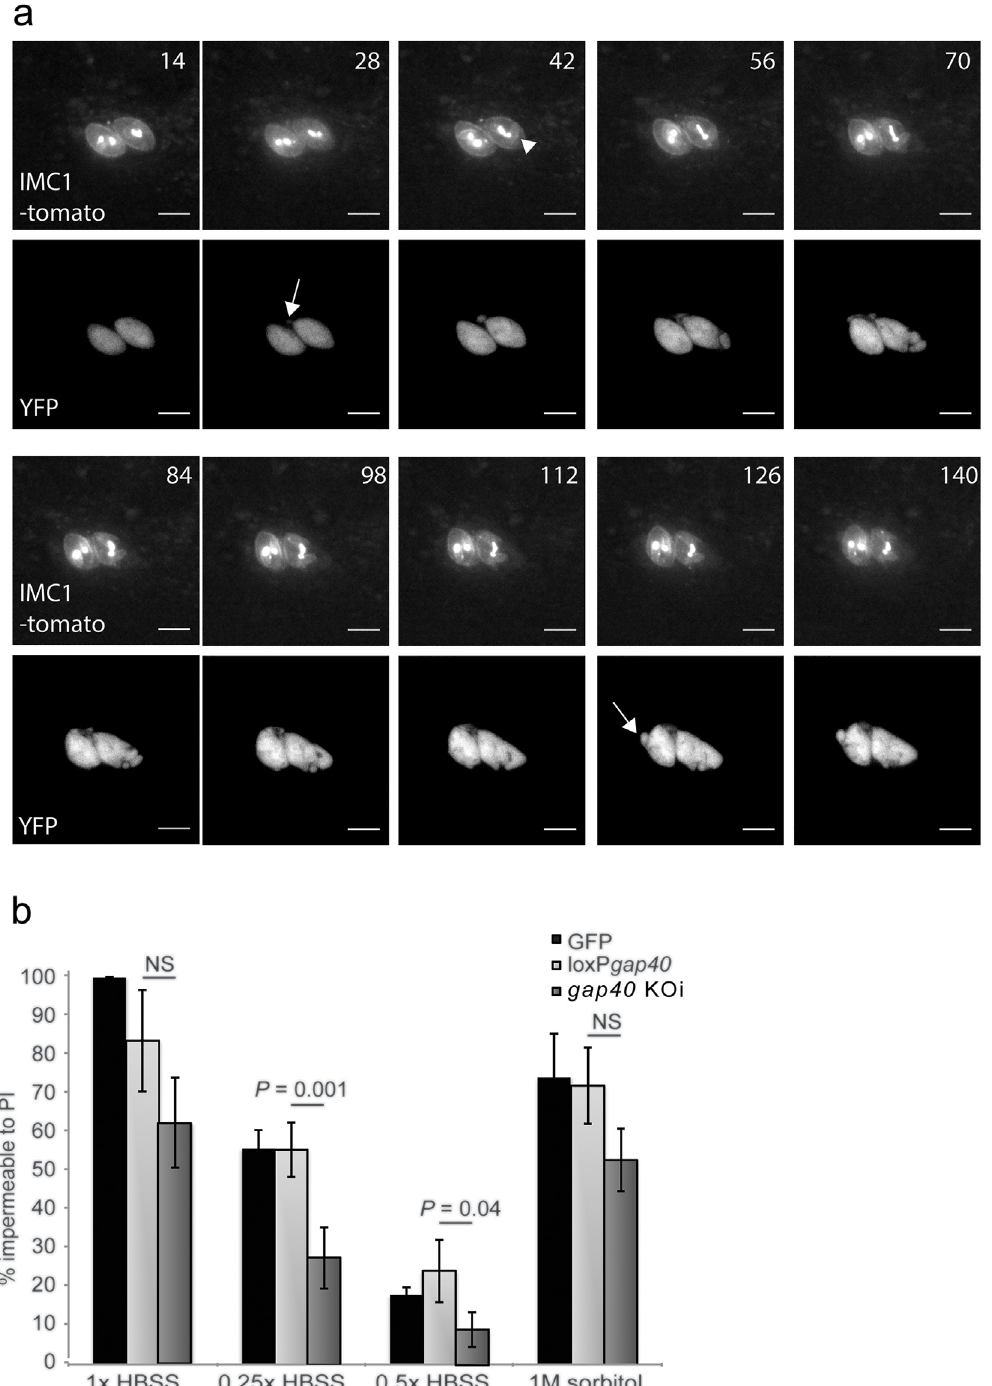
Fig 7. gap40 KOi parasites show dissociation between the plasma membrane and the IMC and show reduced ability to resist osmotic shock. ( a ) gap40 KOi parasites were transiently transfected with imc1-tomato , incubated overnight to allow protein expression then excision was induced. 4 h after the addition of rapamycin, imaging was initiated and images captured every 7 mins, every second image is displayed. YFP signal was observed to appear outwith the IMC boundaries (arrows) followed by loss of the parasite integrity by 42 min (arrowhead). Scale bar 5 μ m. ( b ) At 24 h post induction, parasites were mechanically lysed and treated with either HBSS, HBSS diluted with distilled H 2 O (hypoosmotic) or 1 M sorbitol/HBSS (hyperosmotic) as indicated for 5 mins. The percentage of parasites that remained impermeable to PI was then scored and normalized to untreated GFP parasites. P values are shown between the loxP gap40 and gap40 KOi strains. NS — not significant. Results mean of three independent experiments ± standard